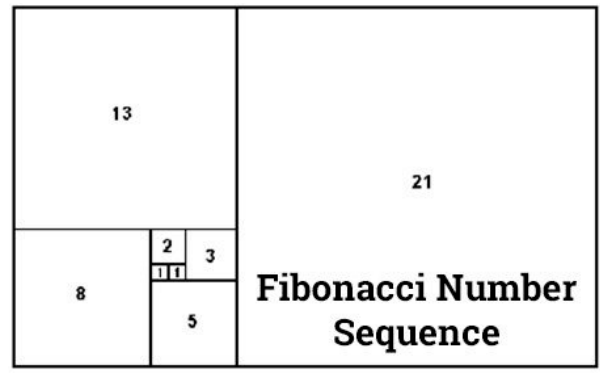
Figure 4. Representation of the golden ratio as the Fibonacci sequence.